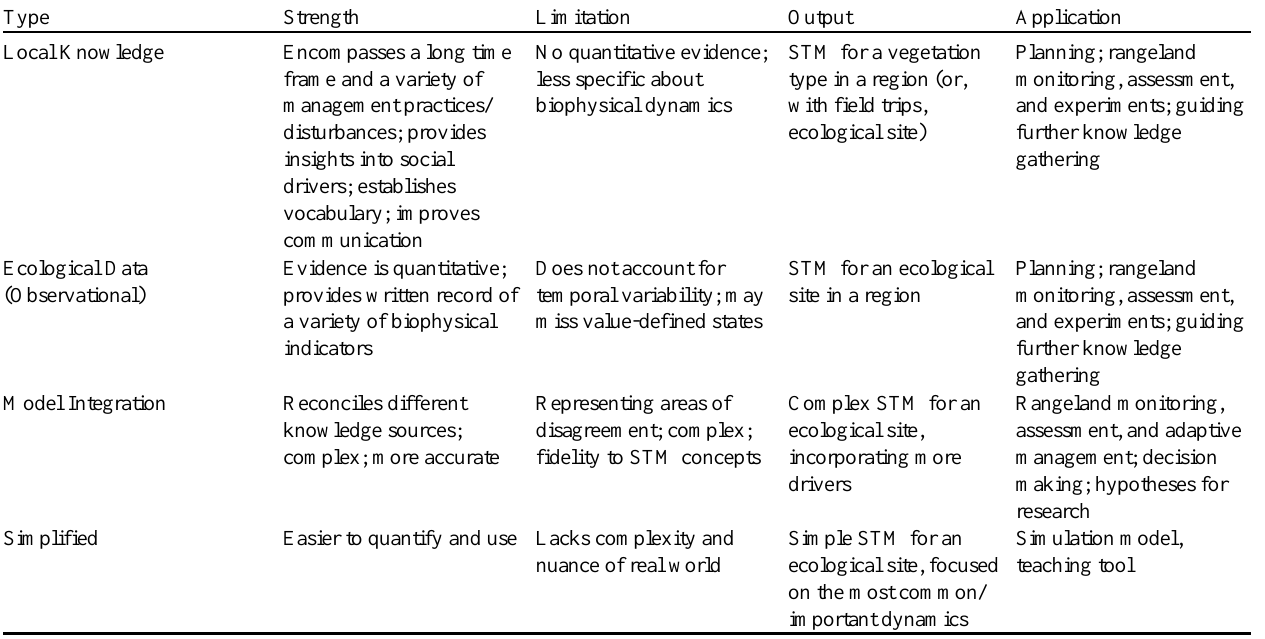
Table 3 . Utility of different sources of knowledge for developing state-and-transition models (STM) for resilience